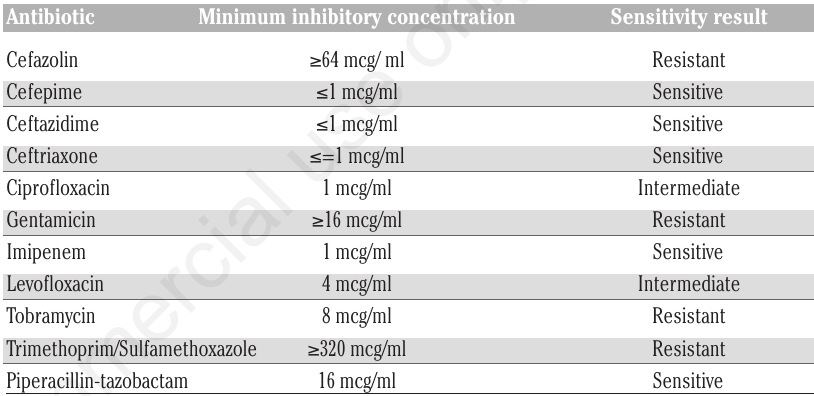
Table 2. Sensitivities of Citrobacter freundii during antibiotic treatment.